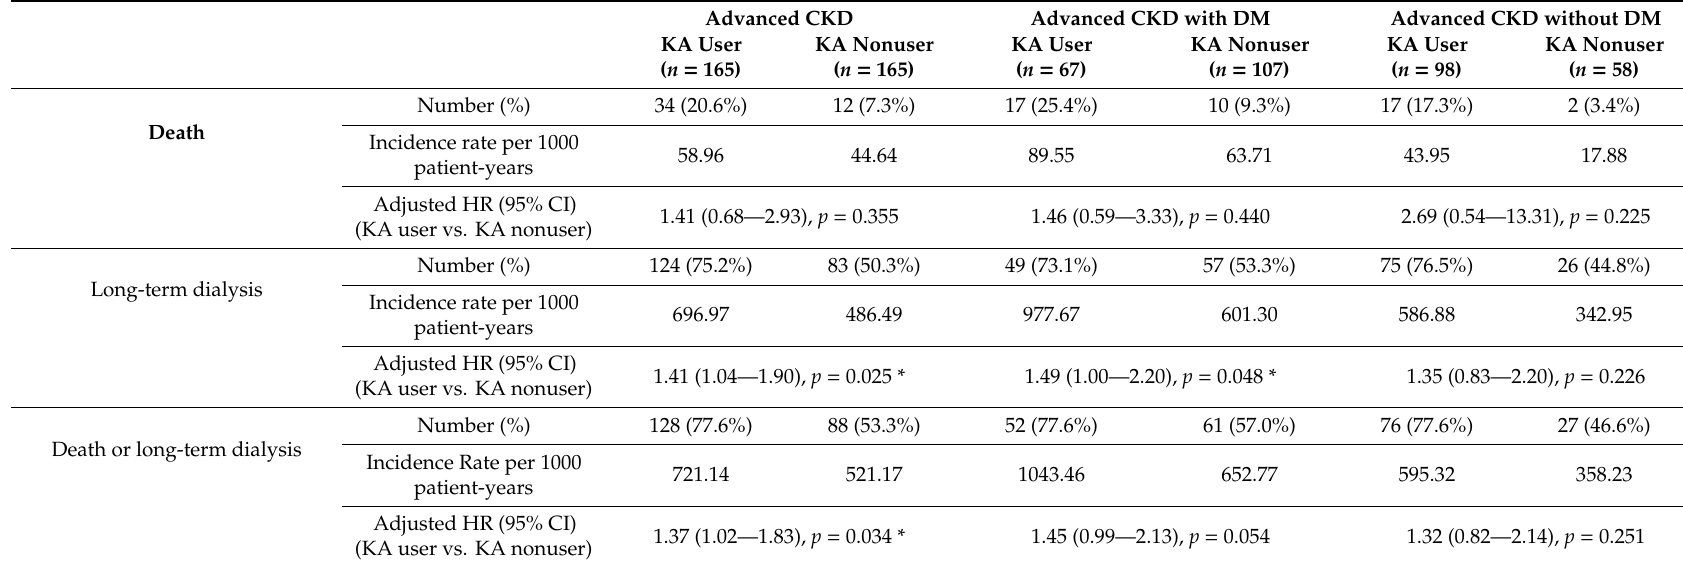
Table 3. Cox proportional hazard model for outcomes in patients with advanced